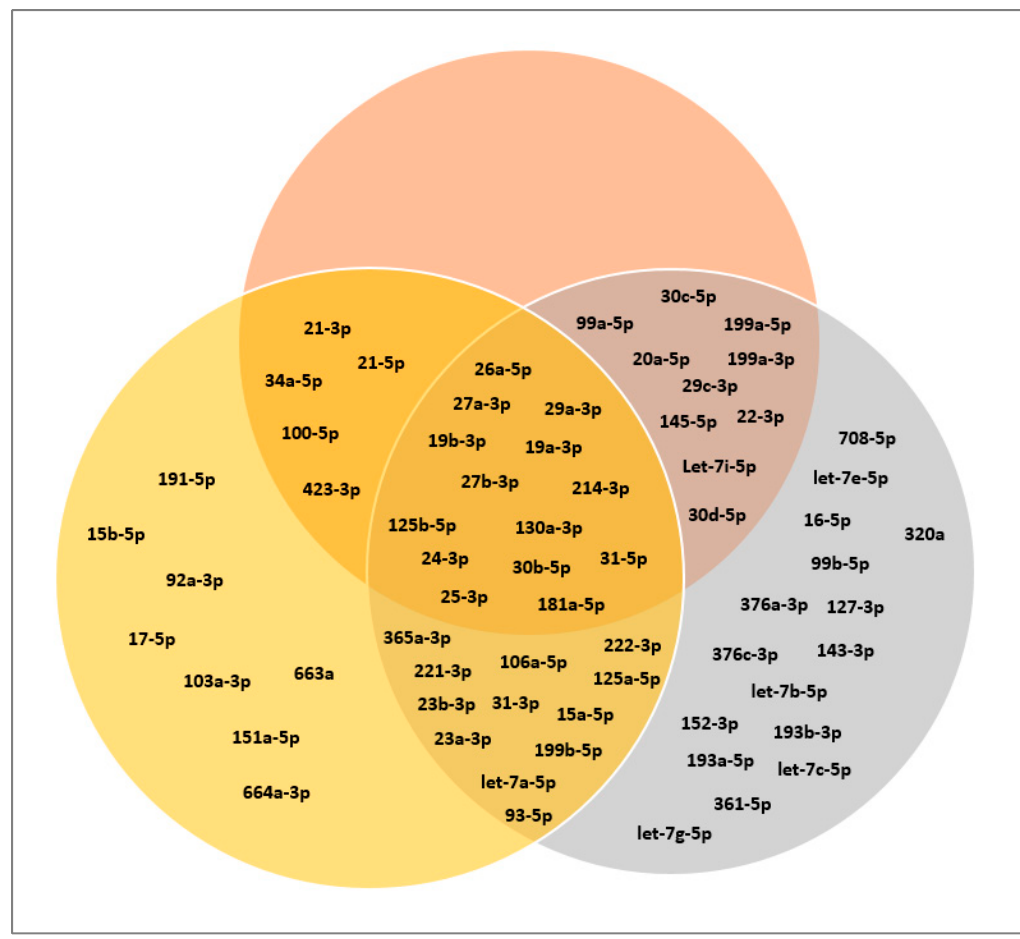
Figure 9. Venn diagram of selected miRNAs based on their function. Gray, tumor suppressor miRNAs; yellow, oncogenic miRNAs; red, cardioprotective miRNAs. With the exception of miR-1260a, all miRNAs with a low mean CTcorr value ( ≤ 29.99) in both CB- and AT-MSC-derived EVs were included. MiR-1260a could not be included, as no targets were described in the literature so far. Further details on these miRNAs are given in Tables A1–A3.